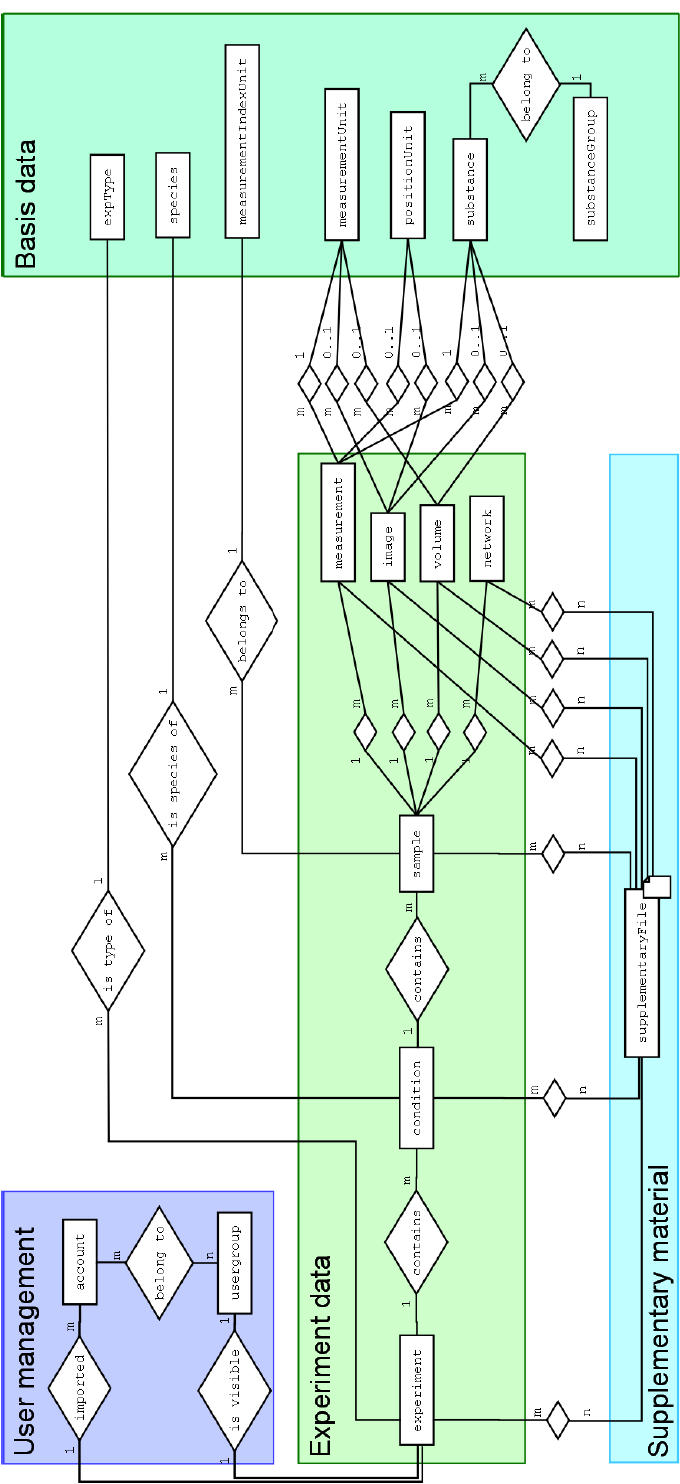
Figure 3: The DBE2 database schema as entity relationship diagram. The database schema com- prises four modules: (i) User management module for user right handling, (ii) Experiment data module for experiment data storage, (iii) Basis data module for controlled vocabulary, and a (iv) Supplementary material module for the association of arbitrary files with entries in the Experiment data